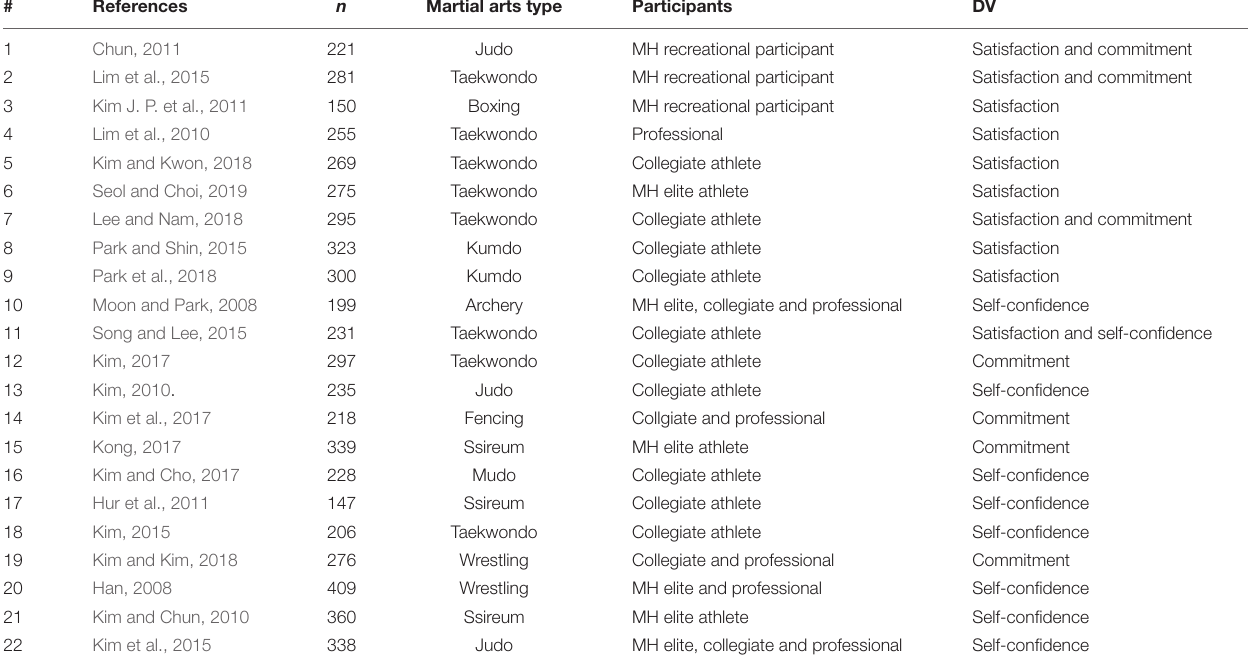
TABLE 1 | Summary of Korean self-management studies in martial